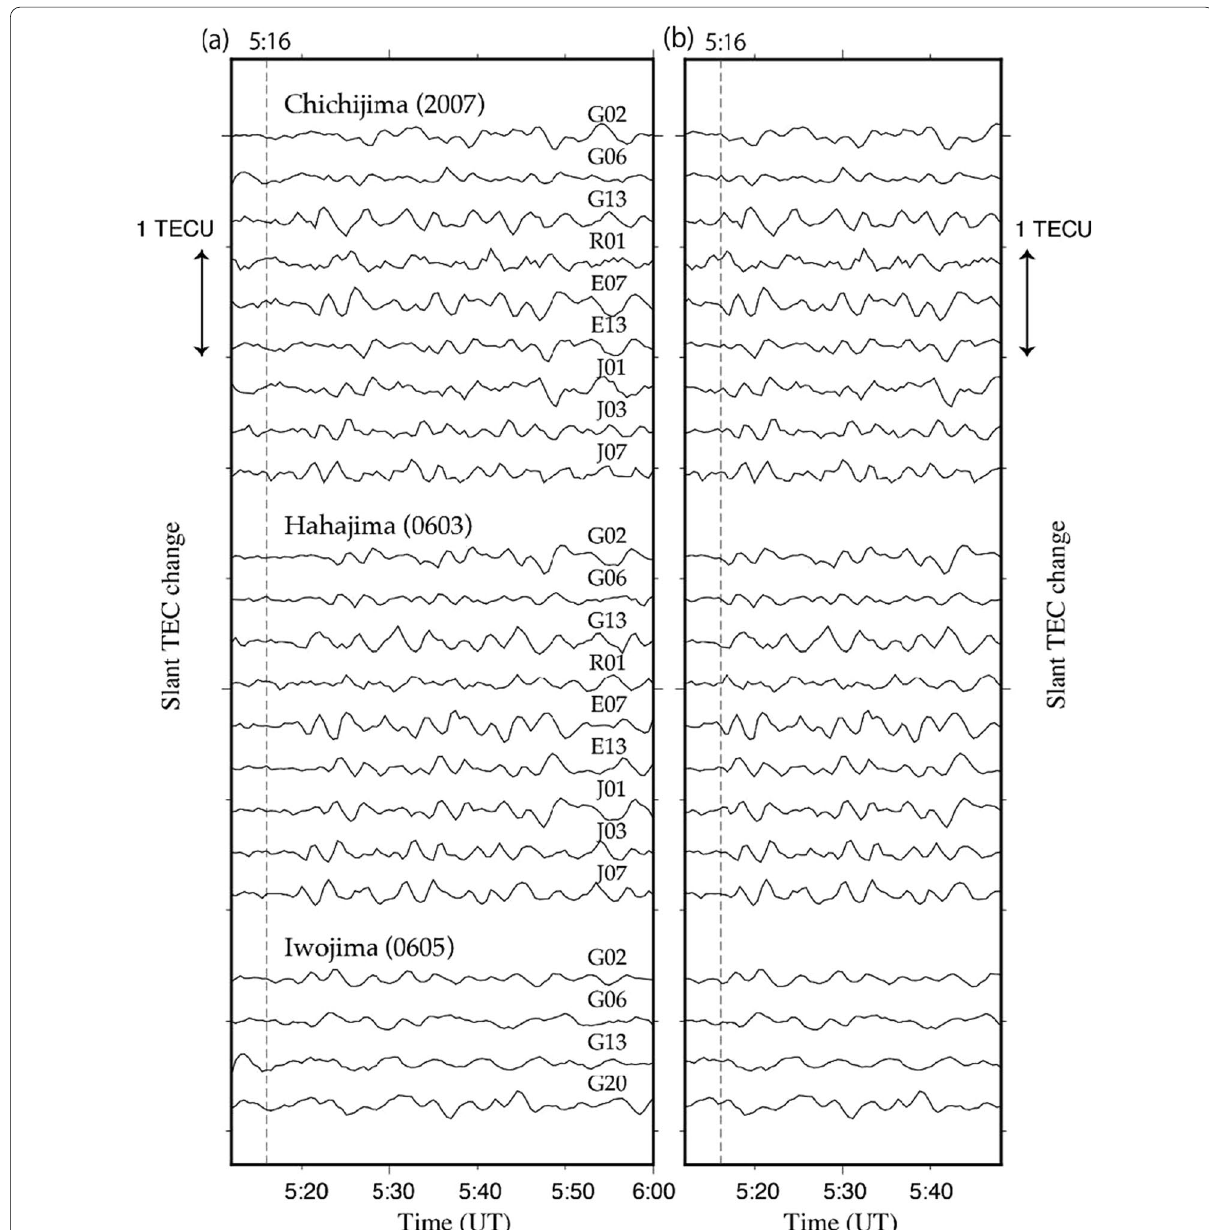
Fig. 3 a High-pass filtered slant TEC time series with various combinations of three stations and satellites of four different GNSS (G, R, E, J indicates GPS, GLONASS, Galileo, and QZSS, respectively). In b , we corrected for the travel time of acoustic wave assuming the propagation velocity of 0.8 km/s and time-variable distances between the volcano and ionospheric piercing points of line-of-sights (altitude assumed as 300 km), to reproduce hypothetical oscillation signals right above the